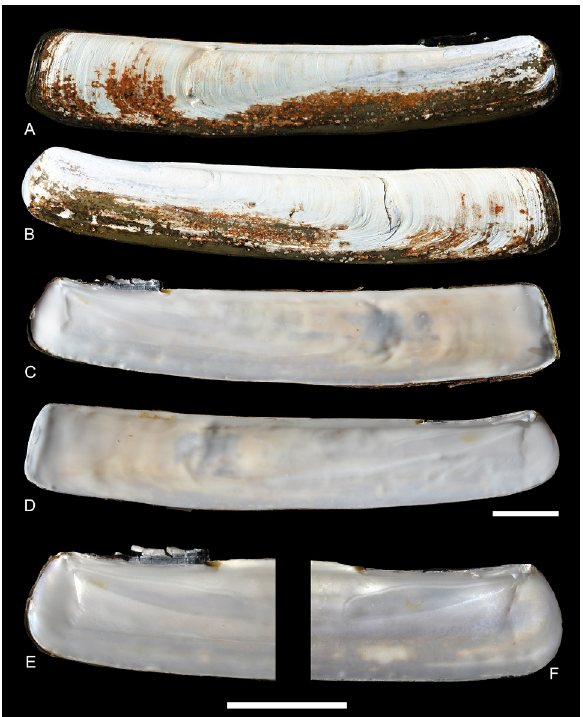
Fig. 5. – Specimens of Ensis macha for comparison. A-B, external view; C-D, internal view; E-F, detail of hinge plate. Scale bar = 2 cm.